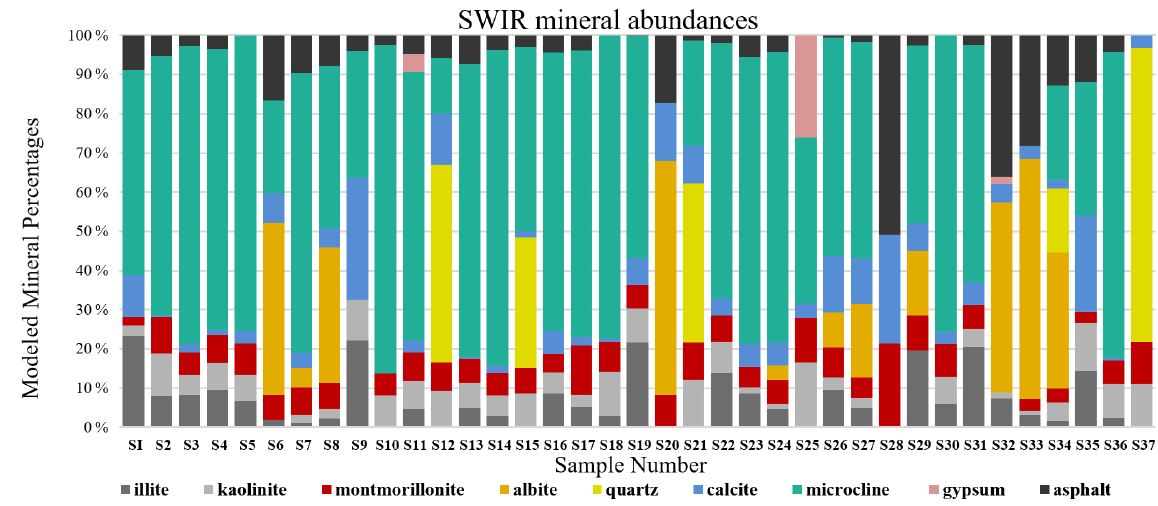
Figure 9. Bar charts show the relative mass fraction (%) calculated from a linear combination of SSA of minerals and asphalt. The unrealis- tically large proportions of microcline, quartz, and albite are discussed in the text.